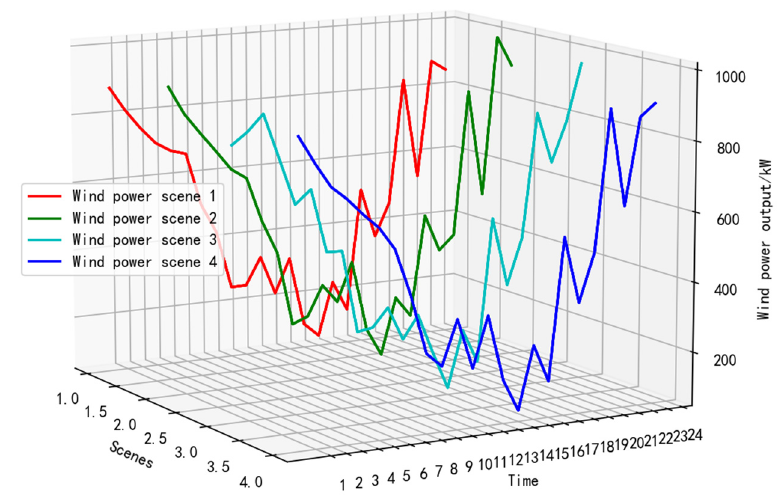
Figure 3. Four wind power classic scene curves.